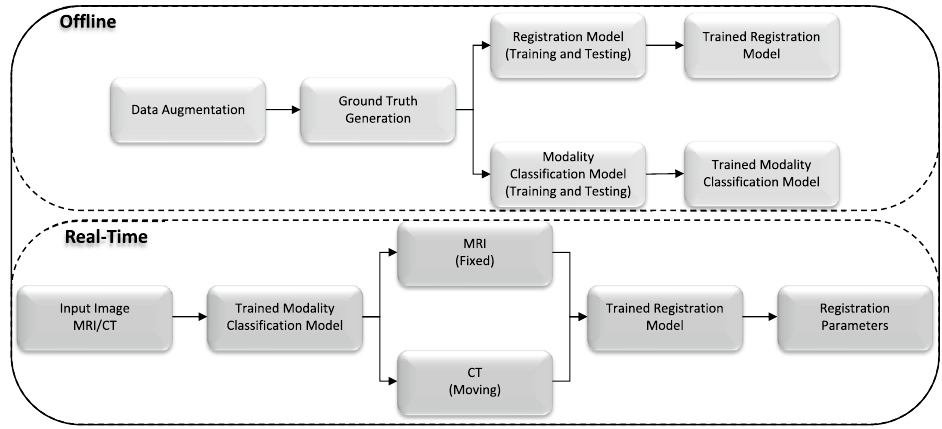
Figure 2. Overview of the proposed registration